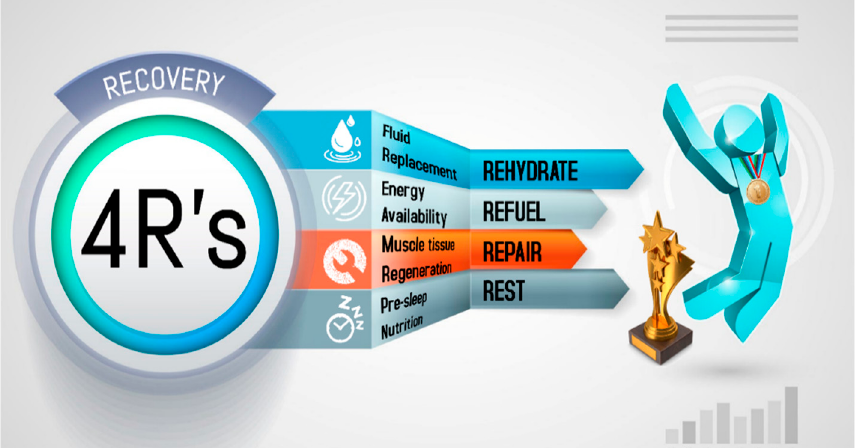
Figure 2. The 4R’s framework of nutritional strategies to optimize post-exercise recovery in athletes.